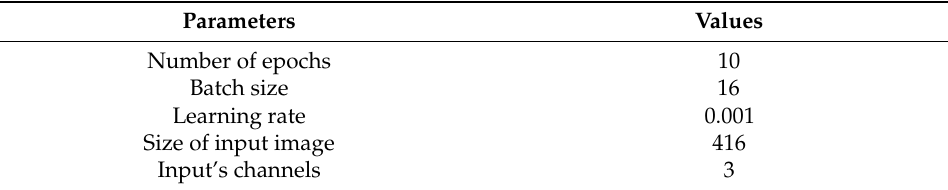
Table 2. First training parameters of the car object detection model.